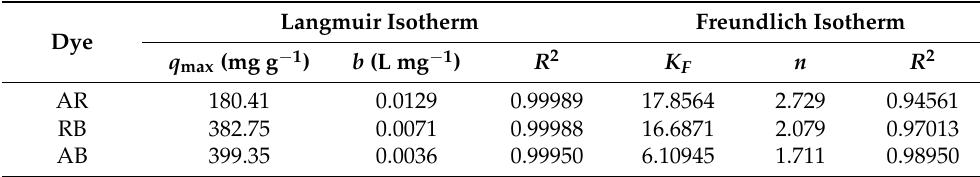
Figure 6. Adsorption isotherms of pMIL-88A/PAN NFM for AR ( a ), RB ( b ) and AB ( c ). Table 2. Calculated results of the Langmuir and Freundlich models for the adsorption of AR, RB, and AB by the pMIL-88A/PAN NFM.